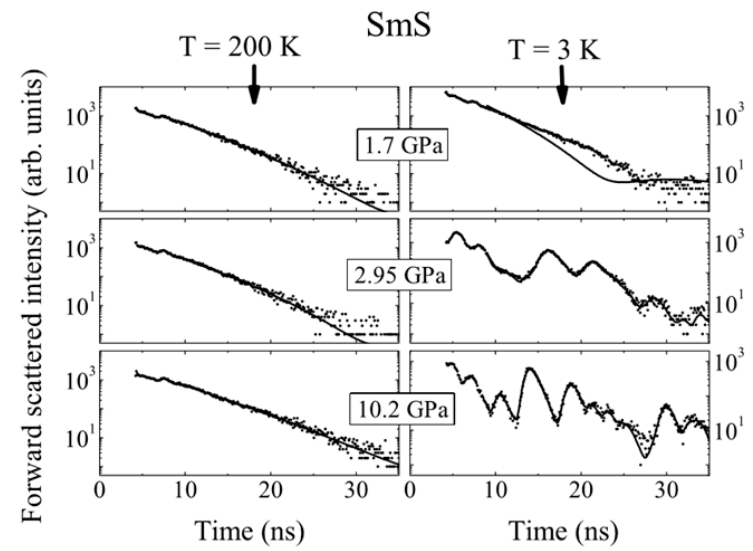
Figure 7. 149 Sm NFS spectra of SmS at different temperatures and pressures. Dots are the experimental results, while the full lines are fits. (Reprinted with permission from [52].)